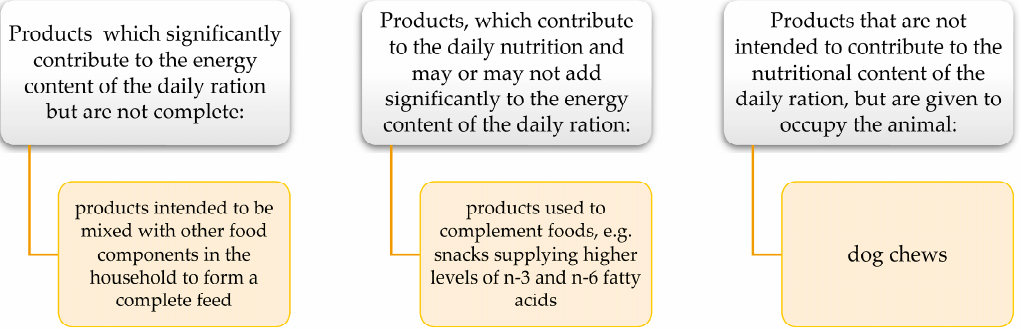
Figure 1. Range of complementary pet food products. Adapted from [7].